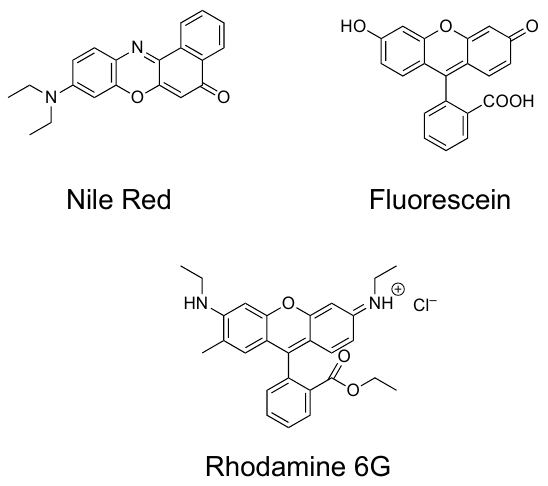
Scheme 1. Molecular structures of fluorescent dyes used in this